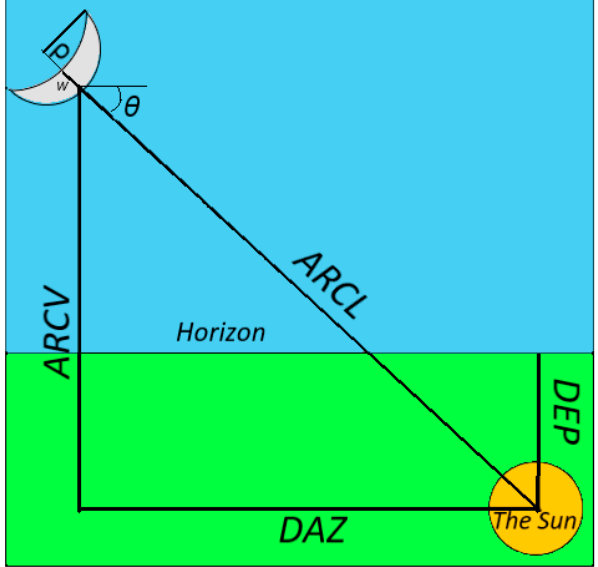
Figure 1. Horizontal Coordinates of the Bright Limb of the Crescent Moon Relative to the Sun, along with other parameters.